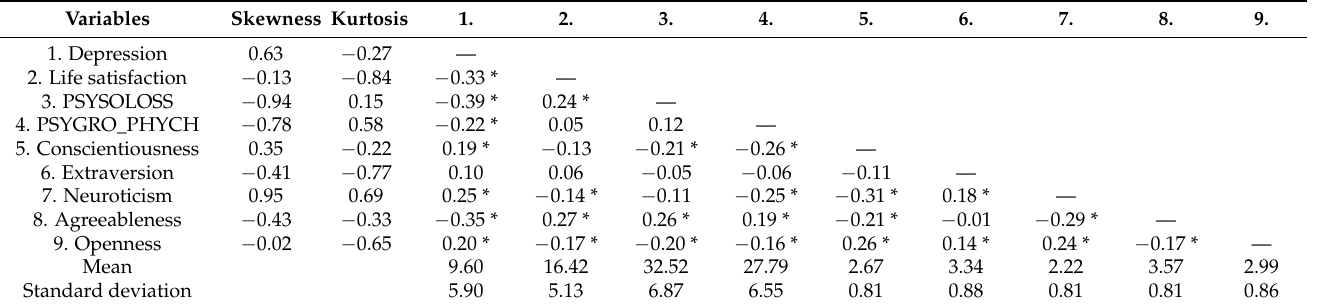
Table 2. Mean, standard deviation, and correlations among the study variables.